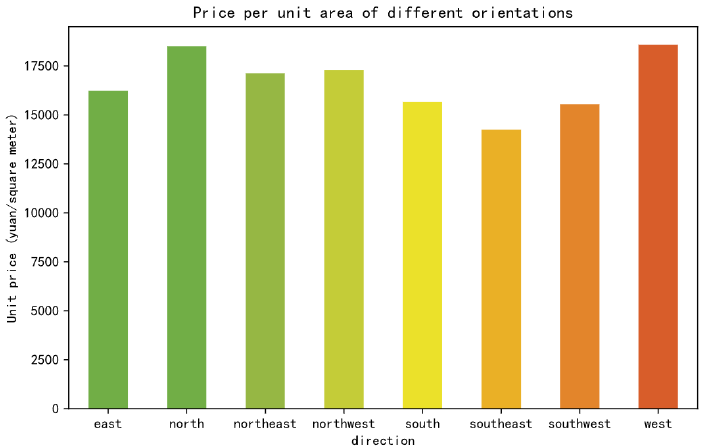
Fig. 7 House prices per unit area in various